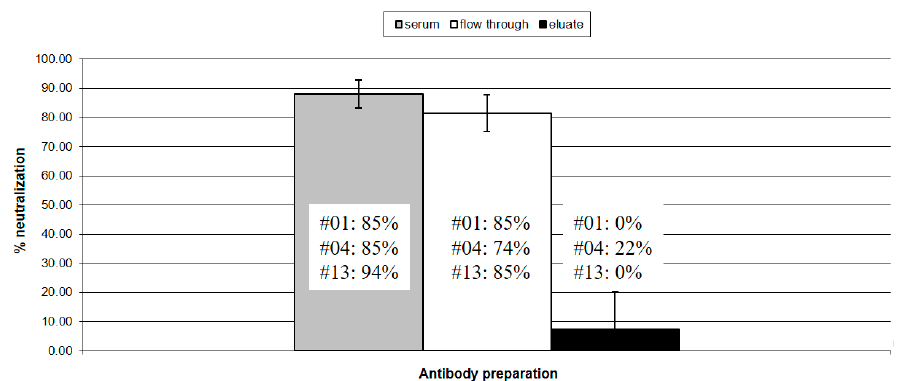
Figure 2. Virus neutralizing activity: The virus neutralizing activity of unfractionated sera (gray column), antibody present in the column flow through (white column) and affinity purified anti-SU5 antibody (black column) were tested in a standard virus neutralization assay using 10 3 TCID50 of CAEV-CO. The histogram shows the neutralization activity of these antibodies, expressed as % neutralization of the input virus. An SRLV antibody negative serum was used as control. Standard deviations were calculated according to the results obtained with the three antibody preparations from goat #01, #04 and #13, respectively. Except for the eluate from goat #4, showing a borderline activity (22%), the affinity purified anti-SU5 antibody was completely devoid of neutralizing activity.